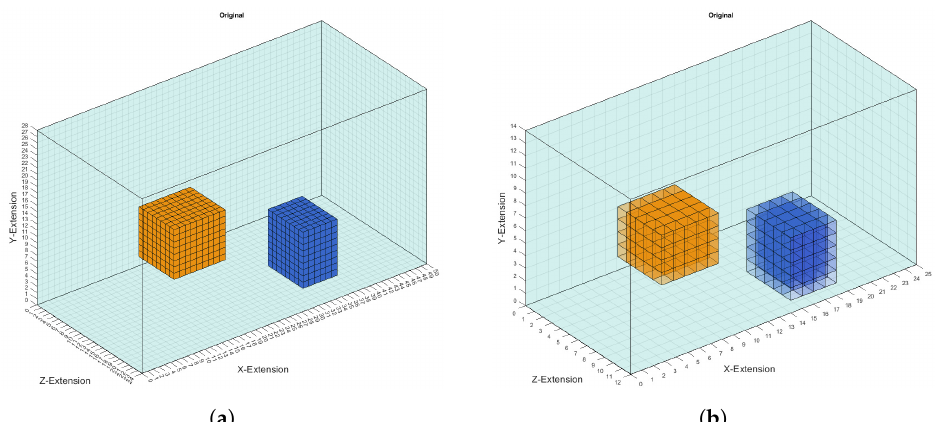
Figure 3. ( a ) Two cuboid perturbation objects set in the voluminous body discretised with 1 cm voxels. The yellow object has a conductivity of 1.0 S/m and the blue one a conductivity of 0.0 S/m. ( b ) The same object as in ( a ) is shown in the coarser grid of 2 cm voxels. The perturbation objects now have conductivity values differing from the original conductivity of 1.0 and 0.0 S/m on the edge of the